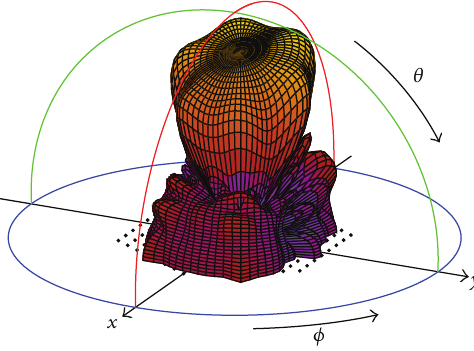
Figure 13: SHA- 169 pattern shaped to 𝑆 𝑟𝑥 .